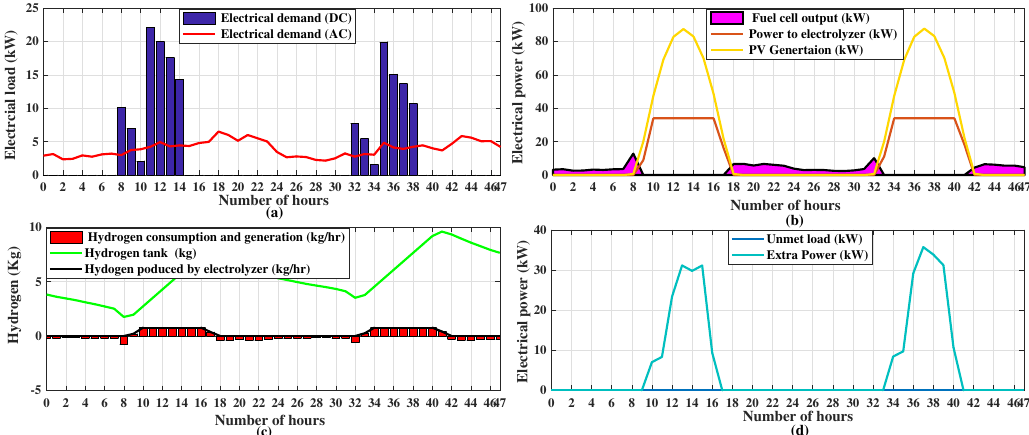
Figure 7. ( a ) Electrical load demand AC and DC both; ( b ) PV, fuel cell output and electrolyzer input power; ( c ) hydrogen balance; ( d ) excess power and unmet